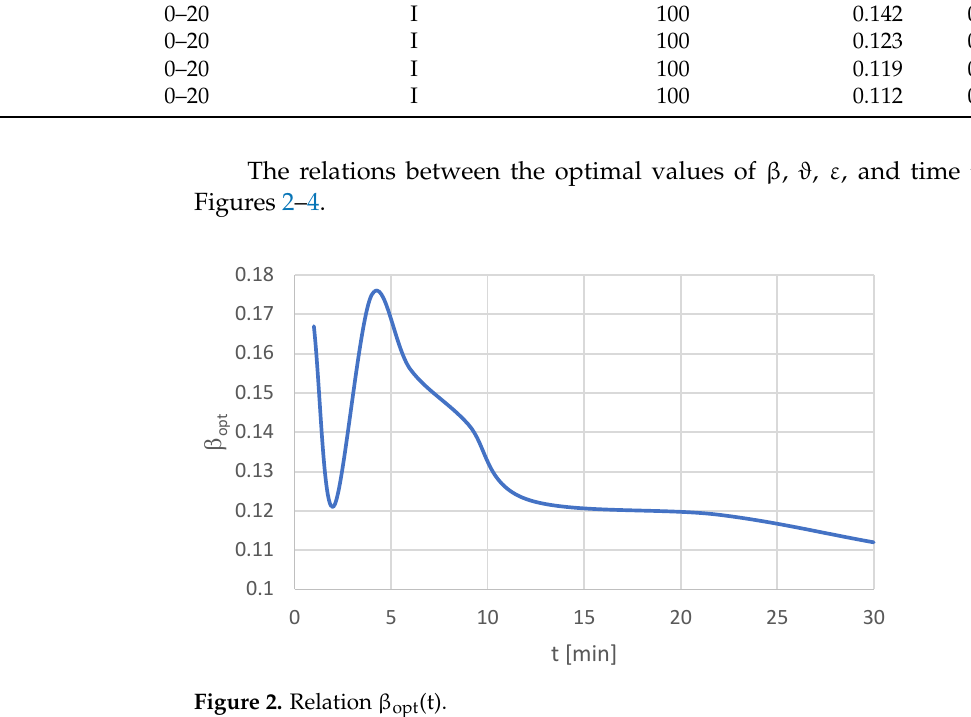
Figure 3. Relation  opt (t).